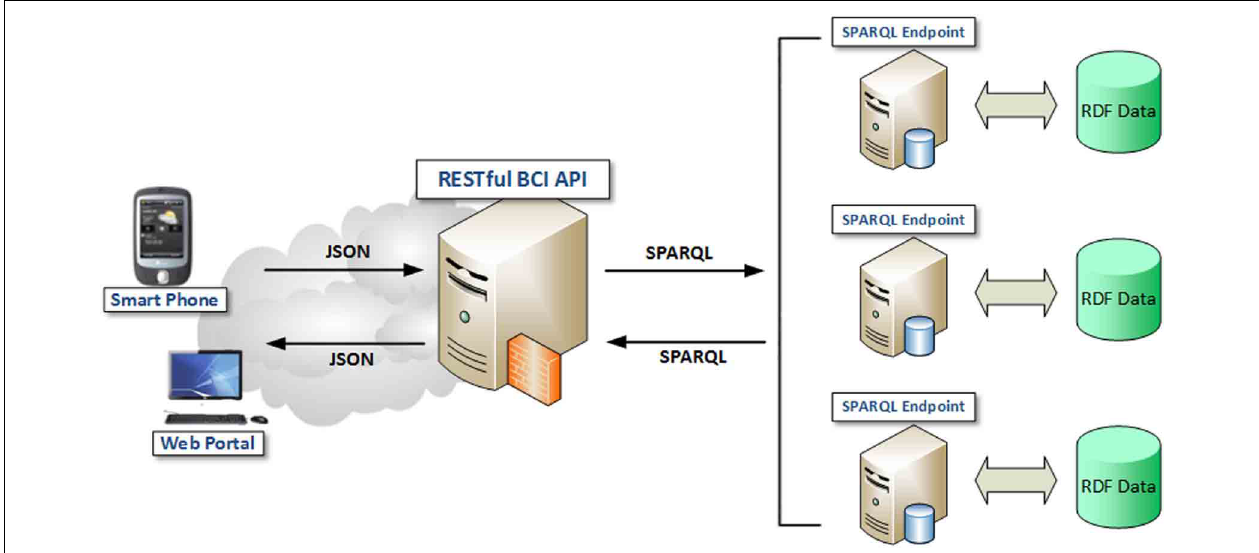
FIGURE 3 | Linked BCI Data Repository over a Federation of SPARQL Endpoints (Rakhmawati, 2013).